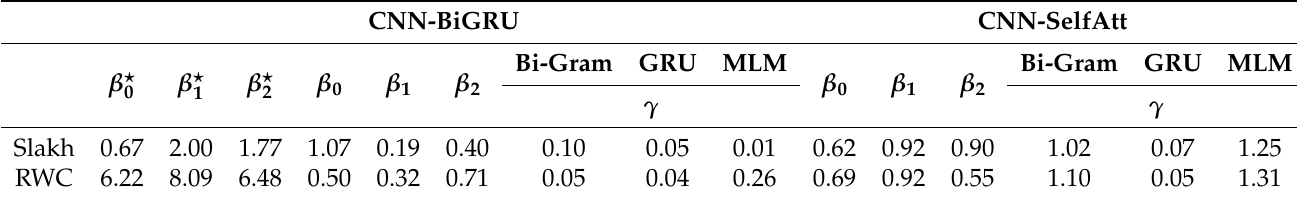
Table 5. Weighting factors optimized by Optuna. m = 0, 1, and 2 represent BD, SD, and HH, respectively. CNN-BiGRU